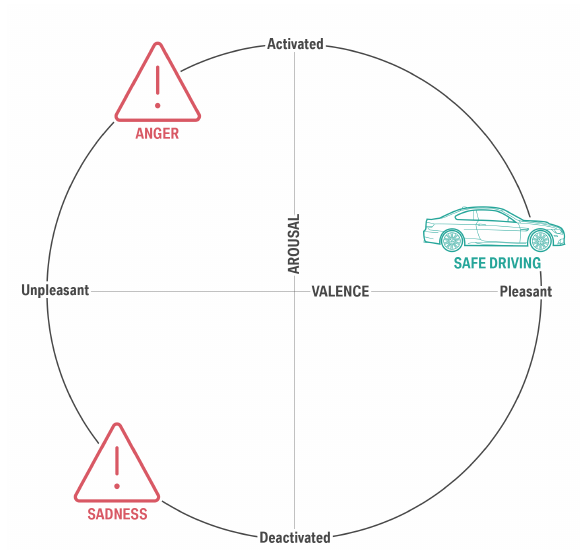
Figure 1. Driver state taxonomy based on Russel’s circumplex arousal-valence model [18] and the Yerkes–Dodson law [19]. Positive valence and medium arousal values have been shown to affect driving in a negative way the